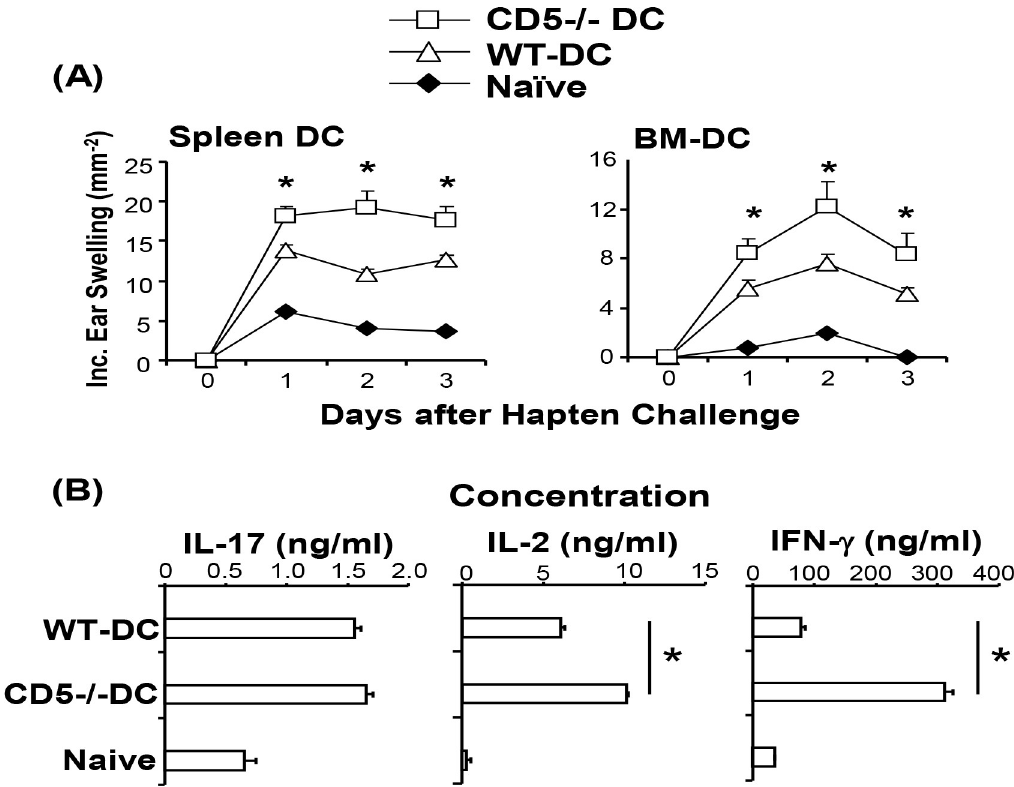
Fig 6. CD5 -/- DC enhance contact hypersensitivity responses (CHS). SP DC or BMDC from WT (WT-DC) or CD5 -/- (CD5 -/- DC) mice were pulsed with DNBS and injected subcutaneously in na ï ve mice. (A). Sensitized mice were challenged with DNFB and ear swelling was measured. Na ï ve mice which were not injected with DC but challenged with DNFB served as controls (n = 5, � P < 0.05). (B) T cells from the draining LN of the immunized mice were stimulated with DNBS-pulsed WT BMDC. Cytokine concentrations were measured by ELISA. T cells from na ï ve mice served as controls (n = 4, � P < 0.05). The data presented are mean ± SEM and are representative of 2–3 independent experiments (two-tailed Student’s t -test).